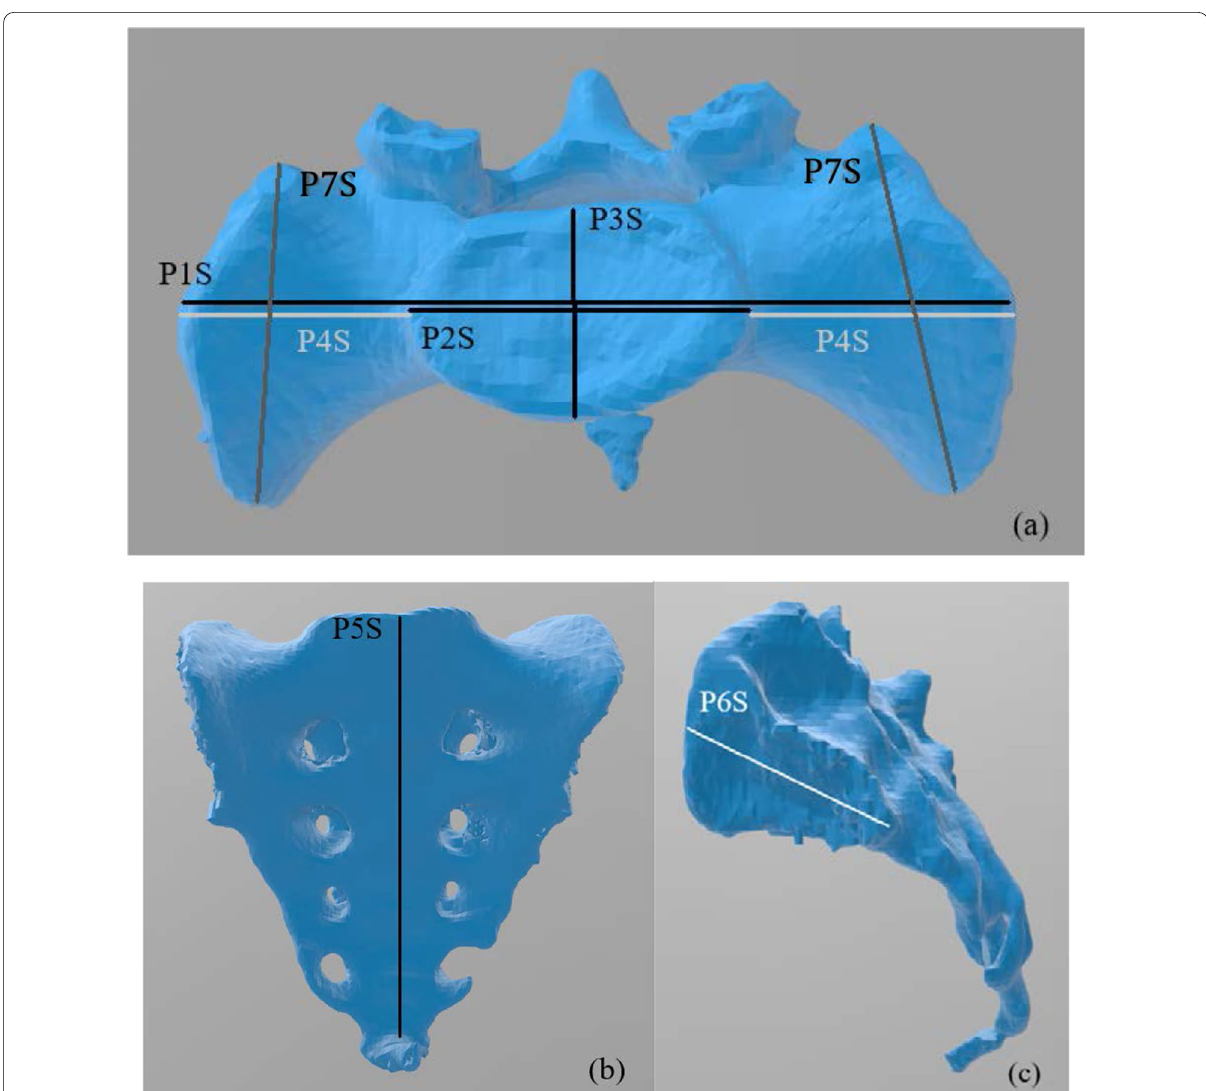
Fig. 2 Inter-landmark distances and parameters shown on the sacrum at superior view ( a ), anterior view ( b ) and lateral view ( c ). Screenshots obtained from Microsoft 3D Builder